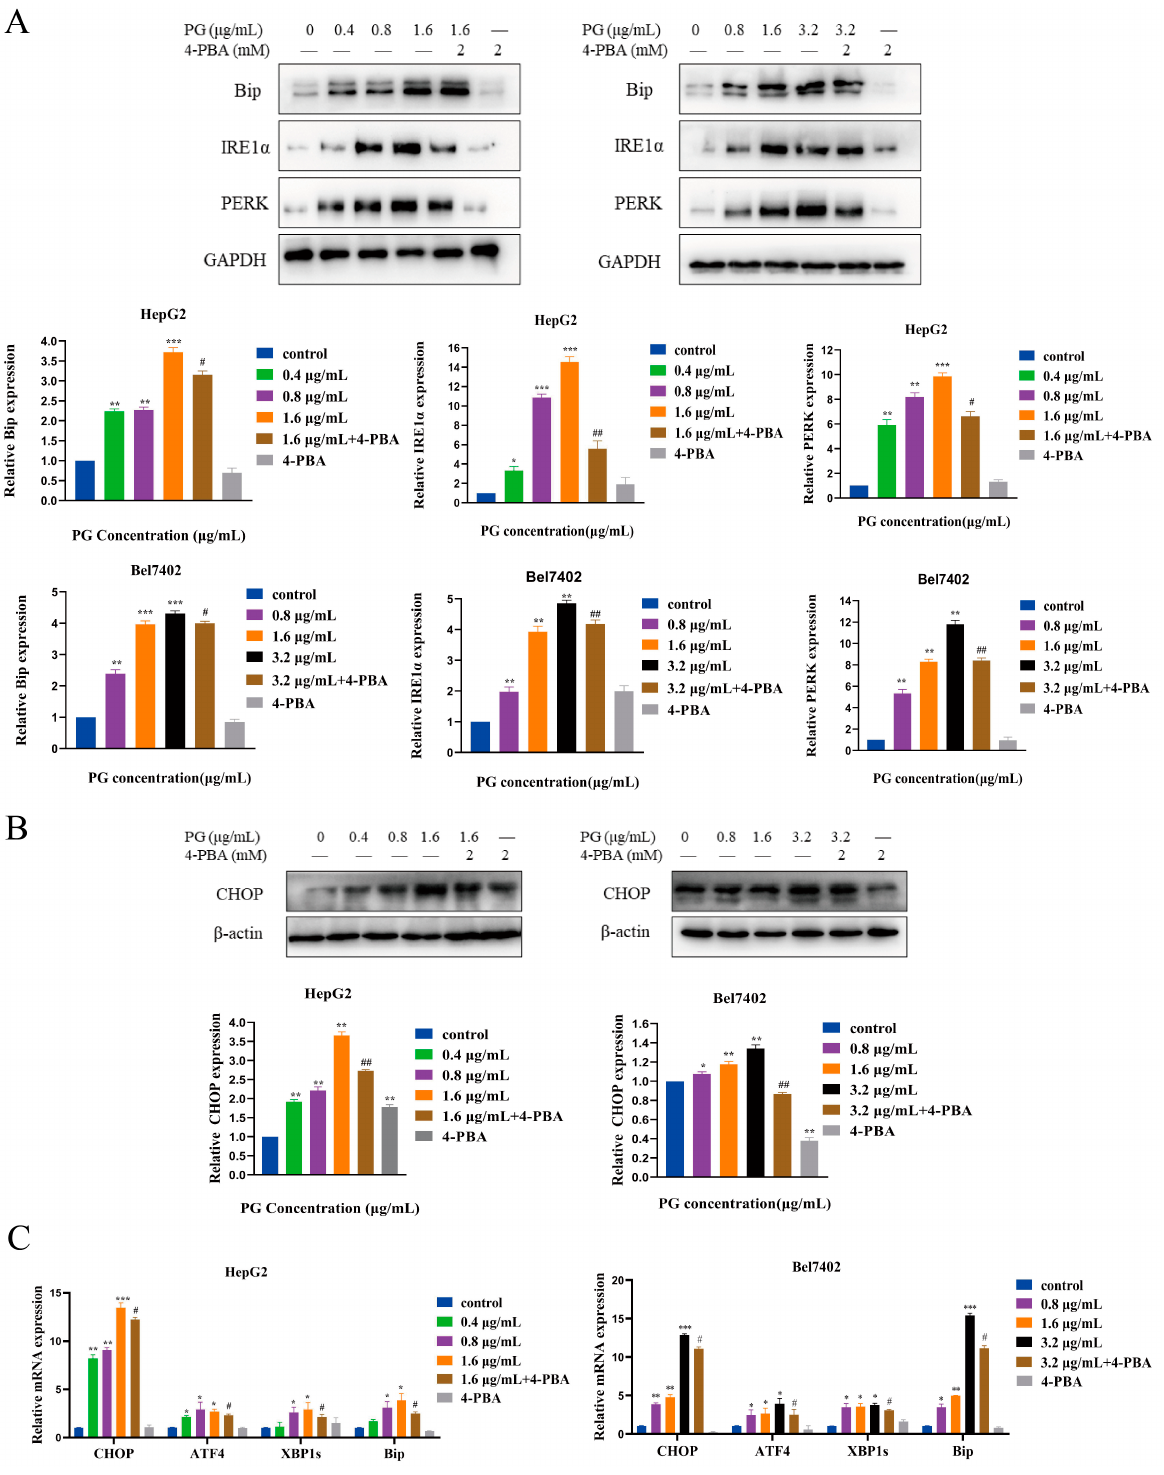
Figure 5. ( A ). Western blot assay on the expression of Bip, IRE1 α , and PERK in HepG2 and Bel7402 cells; ( B ). Western blot assay for the expression of CHOP in HepG2 and Bel7402 cells; ( C ). RT‑qPCR effect of 4‑PBA pretreatment on the effect of PG on the expression of Bip, CHOP, ATF4, and XBP1 mRNA in HepG2 and Bel7402 cells. The treatments included PG (0.4 µ g/mL, 0.8 µ g/mL, 1.6 µ g/mL, 3.2 µ g/mL) vs. 0 µ g/mL of PG; 1.6 µ g/mL of PG vs. 1.6 µ g/mL of PG + 4‑PBA; 3.2 µ g/mL PG vs. 3.2 µ g/mL of PG + 4‑PBA; * p < 0.05, ** p < 0.01, *** p < 0.001, # p < 0.05, ## p < 0.01, n =